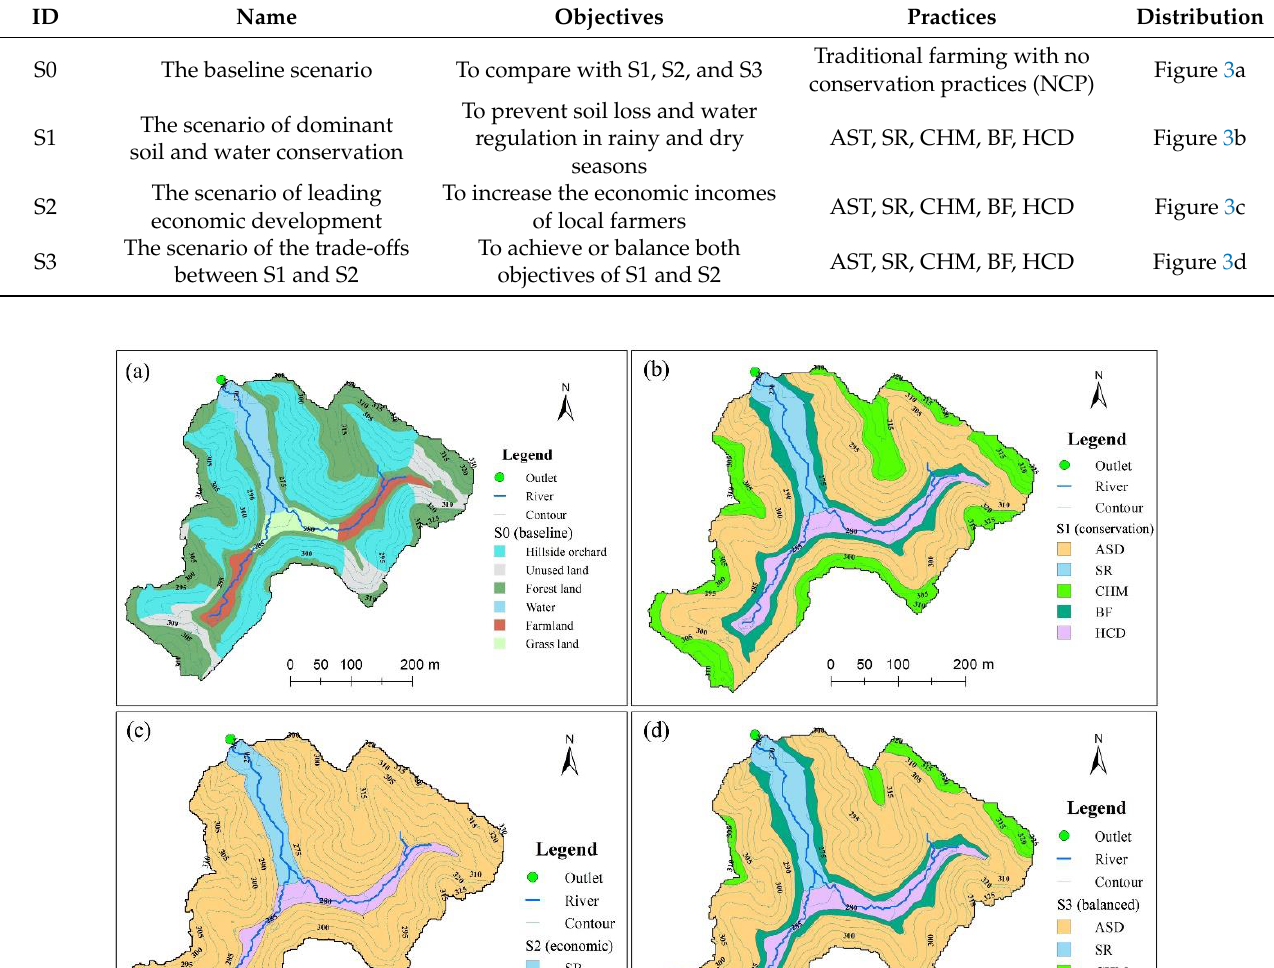
Table 2. The description of baseline scenario and alternative scenarios.